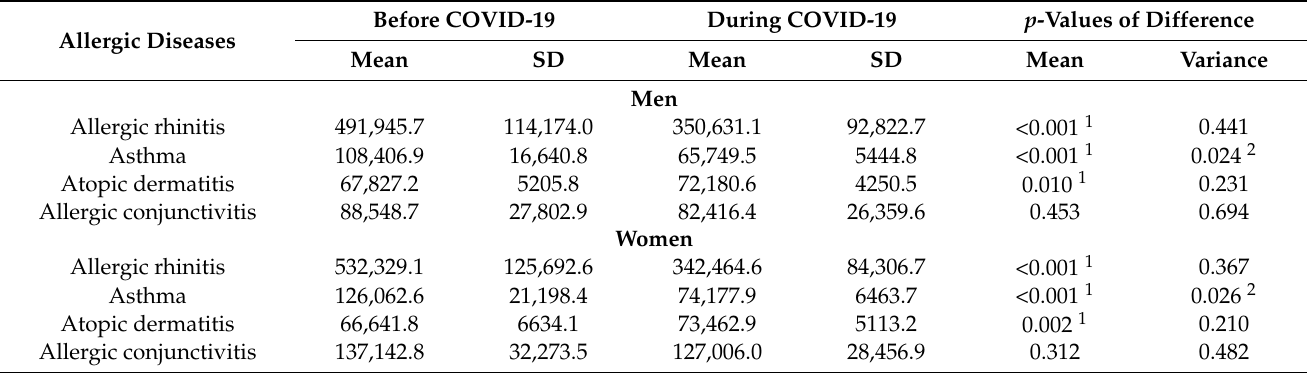
Table 2. Monthly numbers of patients treated for allergic diseases before and during the COVID-19 pandemic and the differences in the subgroups divided by sex.